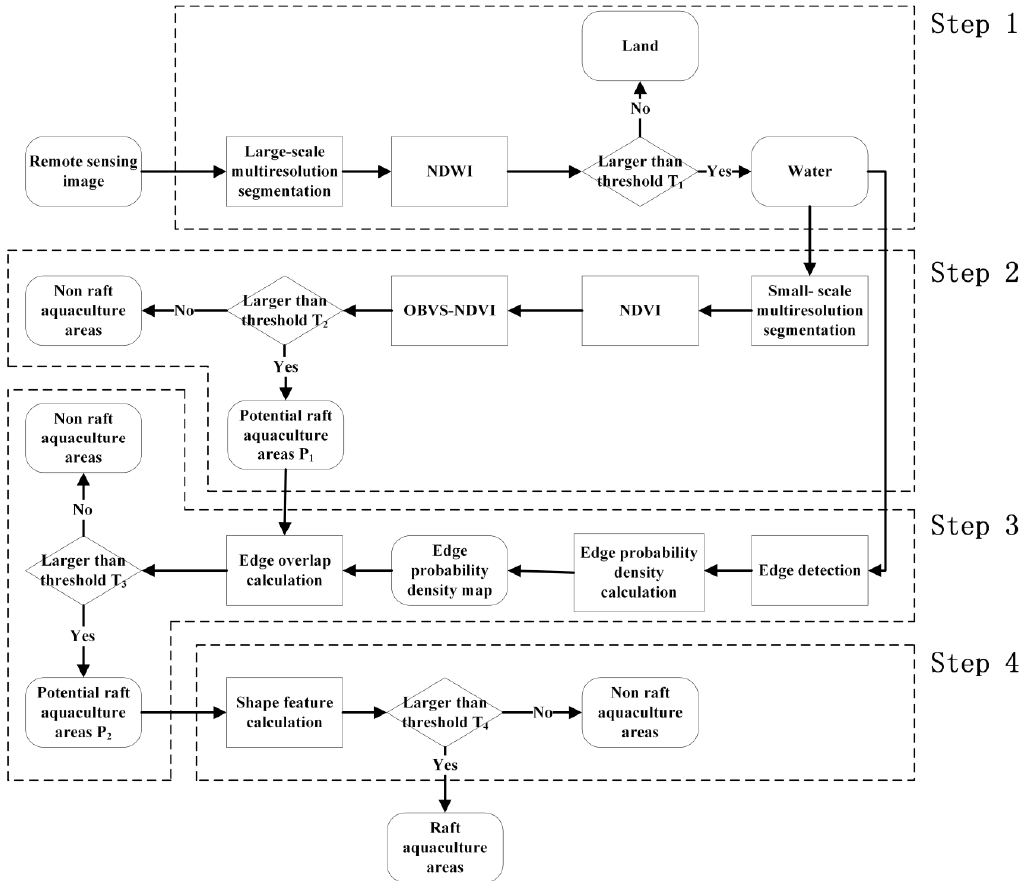
Figure 1. Workflow of the proposed raft aquaculture extraction method. Note: NDVI, Normalized Difference Vegetation Index; OBVS-NDVI, Object-Based Visually Salient NDVI; NDWI, Normalized Difference WaterIndex; P 1, the potential raft aquaculture areas extracted by OBVS-NDVI; P2, the potential raft aquaculture areas extracted by overlap degree of the edge and OBVS-NDVI features of the raft aquaculture area; T 1 , T 2 , and T 3 , represent three key initial thresholds in target segmentation: NDWI threshold T 1 for water-land separation, OBVS-NDVI feature extraction for potential raft aquaculture area threshold T 2 , and edge overlap threshold T 3 ; T 4 , the threshold value 1.5 times of the standard width of the patch in the actual raft aquaculture.